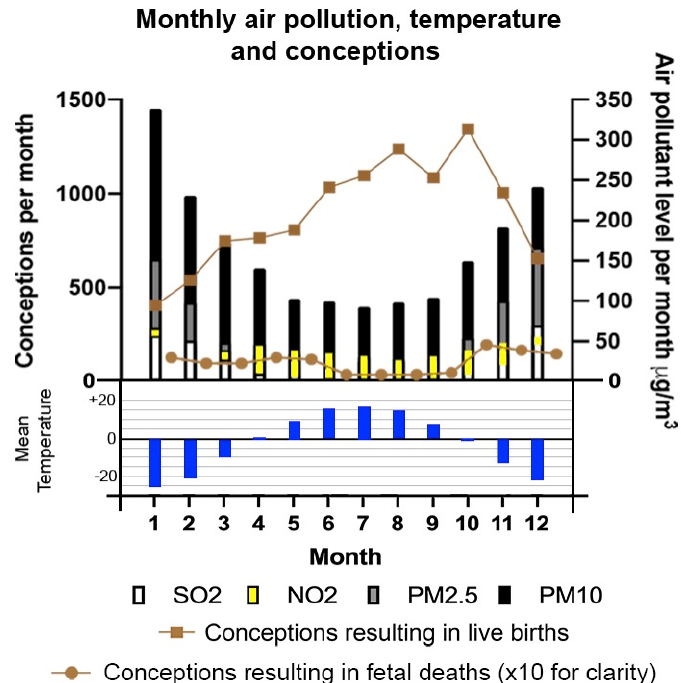
Figure 2. Monthly successful conception rates (brown line with squares) versus the mean total monthly air pollution concentrations with SO 2 (white bars), NO 2 (yellow bars), PM 2.5 (gray bars), and PM 10 (black bars). Monthly conception rates that resulted in early (<20 weeks) fetal death (brown line with circles). The latter data has been taken from our previous study in 2011 by Enkhmaa et al., normalized [13] and multiplied by 10 for clarity. The mean monthly temperature is plotted below (blue bars).